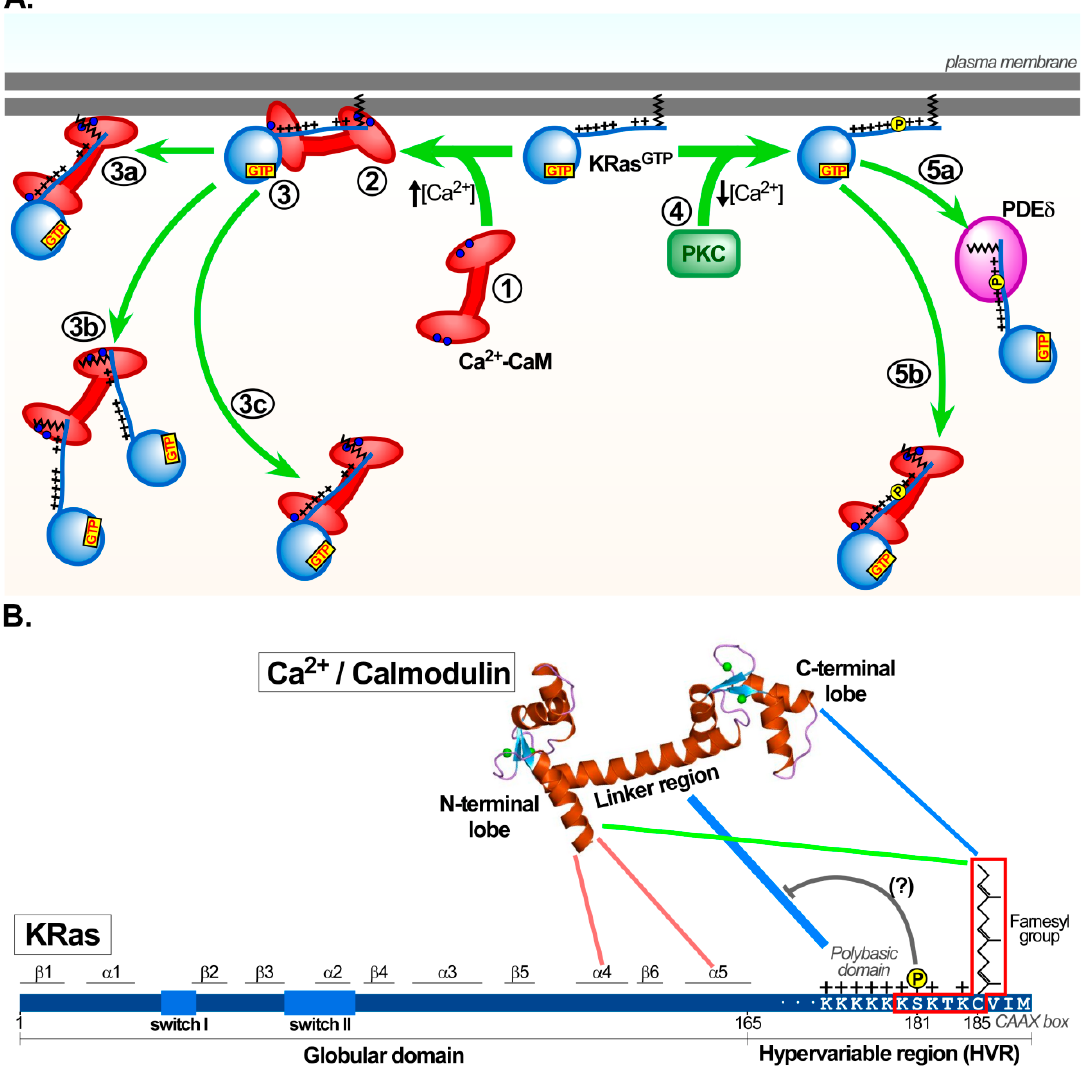
Figure 1. Calmodulin / KRas interaction motifs and their role in KRas tra ffi cking. The di ff erent possibilities how calmodulin may a ff ect KRas tra ffi cking (A) and the protein domains facilitating the interaction of calmodulin and KRas are shown (B). ( A ) Role of calmodulin in KRas tra ffi cking routes. ( 1 ) Upon elevation of intracellular [Ca 2 + ] levels, Ca 2 + binds and activates calmodulin (Ca 2 + -CaM), which preferentially interacts with active KRas (KRas-GTP) at the plasma membrane. ( 2 ) Initially, the C-terminal lobe and the linker region of Ca 2 + -CaM interact with the polybasic domain of KRas. The negatively charged Ca 2 + -CaM linker region is attracted to the polybasic KRas domain through electrostatic coupling. This may be followed by a conformational change in both proteins that permit a secondary interaction between the N-terminal lobe of Ca 2 + -CaM with the globular domain of KRas, in particular with helices α 4 and α 5. ( 3 ) The majority of Ca 2 + -CaM / KRas complexes remain associated with the plasma membrane. However, to some extent, the hydrophobic C-terminal lobe of Ca 2 + -CaM interacts and extracts the KRas farnesyl group from the lipid bilayer. ( 3a ) KRas could remain at the plasma membrane through the interaction of Ca 2 + -CaM with the acidic membrane leaflet or through interaction with other proteins that are recruited to the plasma membrane, such as phosphoinositide 3-kinase (PI3K). ( 3b ) Alternatively, after binding of the C-terminal lobe of Ca 2 + -CaM to KRas,